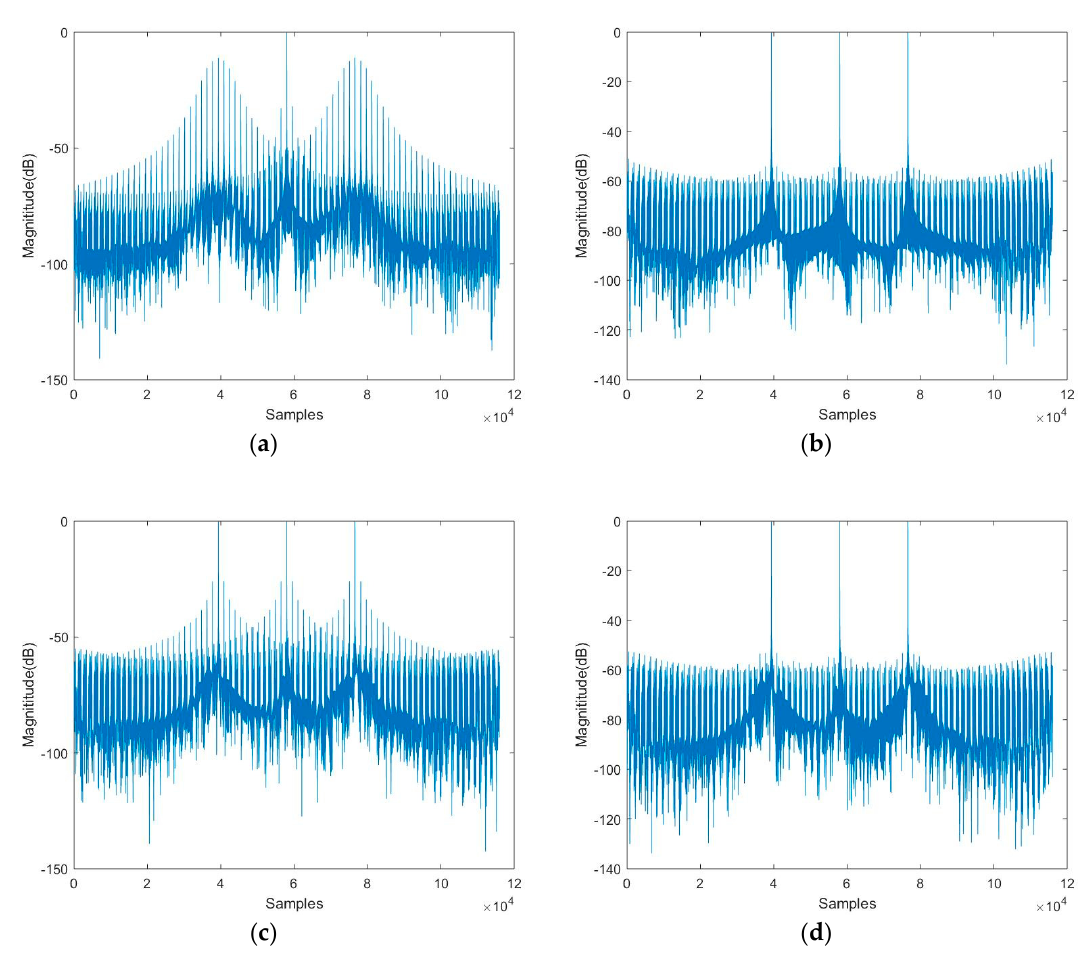
Figure 5. Nonuniform sampled signal with fast PRI change after compression. ( a ) Compression result with FFT. ( b ) Compression result with NUDFT. ( c ) Compression result with sinc interpolation. ( d ) Compression result with modified sinc interpolation.